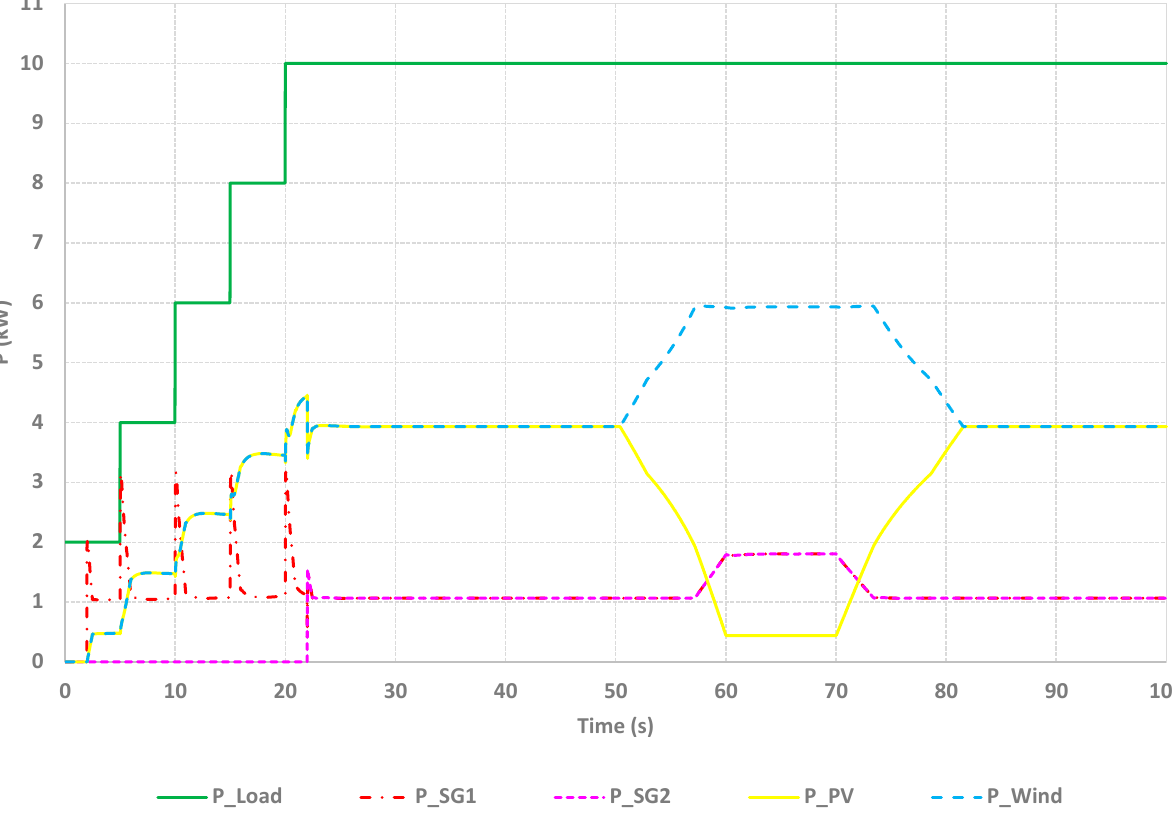
Figure 8. Scenario 3b: Cloud transient analysis for maximum solar PV and wind generation for a 10 kW demand.